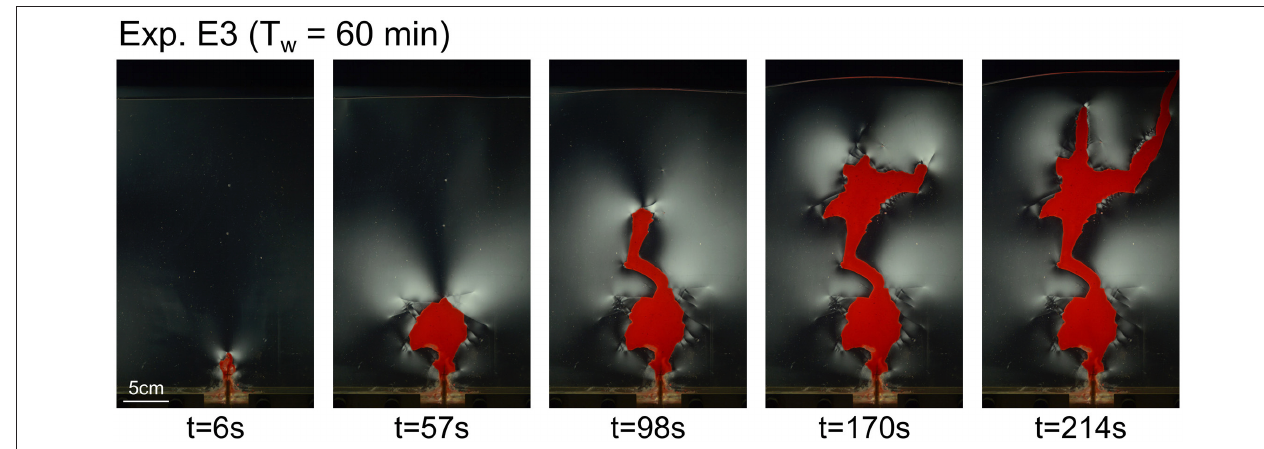
FIGURE 6 | Time series of polarized light photographs of Experiment E3 ( T w = 60 min).